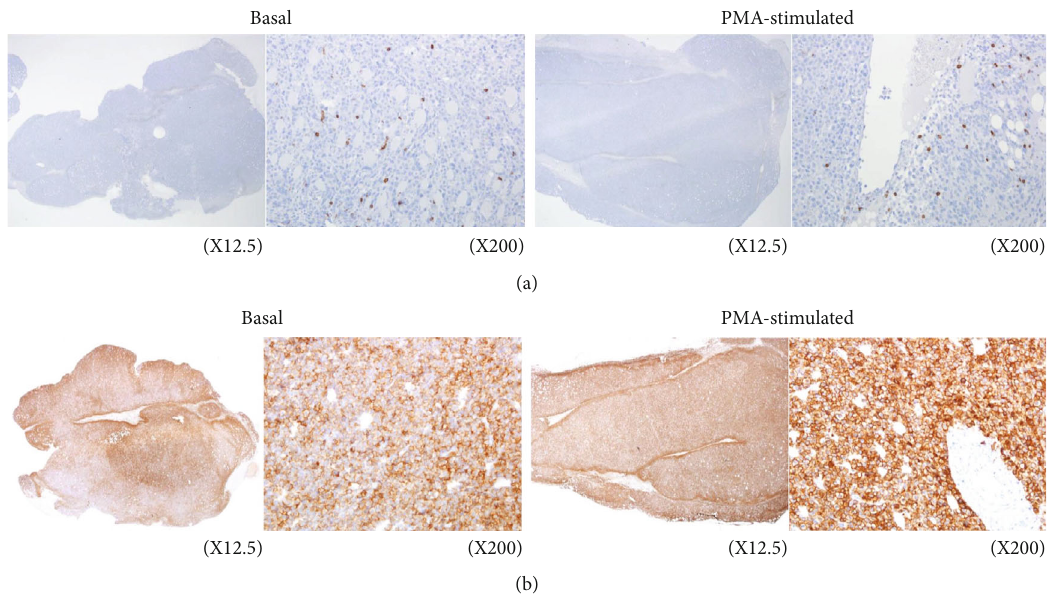
Figure 7: Immunohistochemistry of EL4 tumor tissue of mice with and without PMA treatment. CD8 α staining showing tumor-in fi ltrating e ff ector lymphocytes (a) and PD-1 staining of tumor cells and lymphocytes (b) in tumors of control and PMA-treated mice. Magni fi cation, × 12.5 (left) and × 200